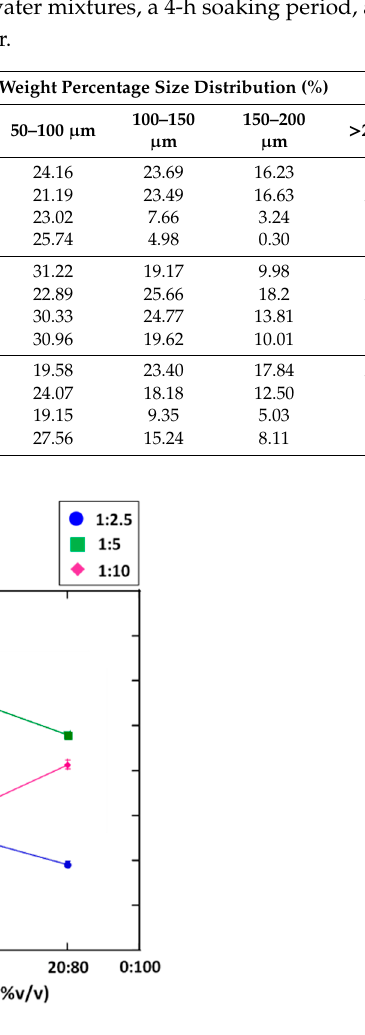
Table 2. Analysis of particle size and weight percentage size distribution of cenospheres collected